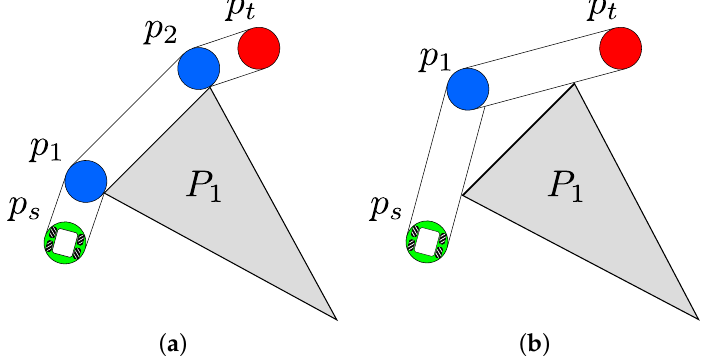
Figure 4. Exploration in the path-planning problem: ( a ) a path with minimum length using two control points and ( b ) a longer path using a single control point.